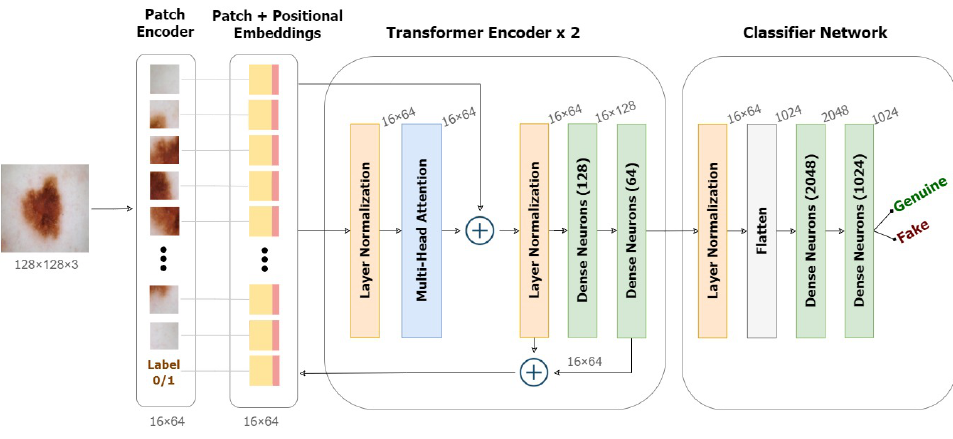
Figure 7. Framework of the Detection model based on Vision